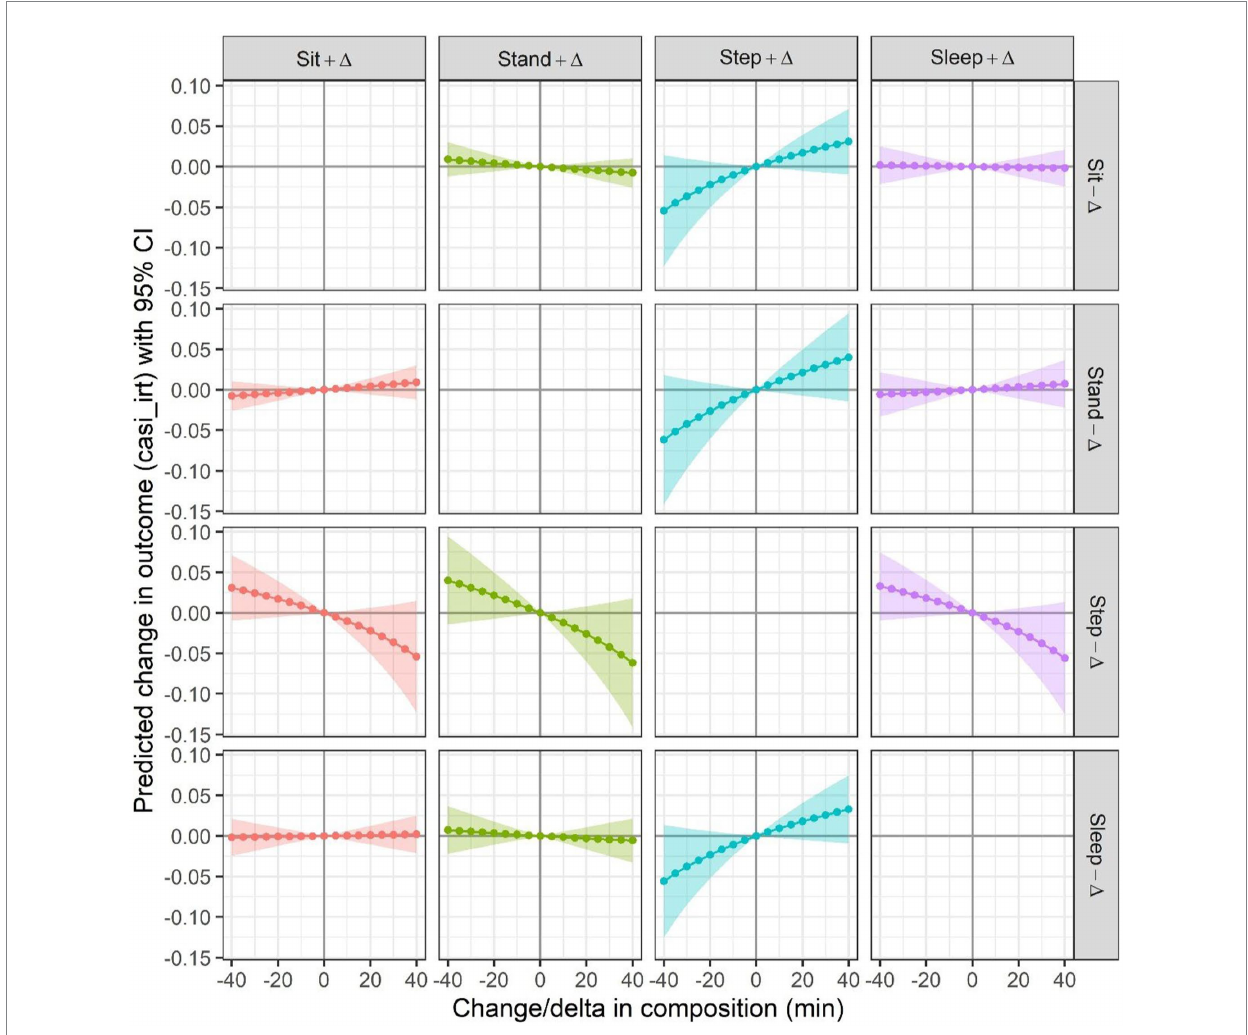
FIGURE 3 Predicted difference in outcome from CoDA when reallocating time from one behavior to another, for all possible pairwise reallocations. N = 1000 (34 observations were not included due to missing values on covariates). Each one of 16 subgraphs presents a curve of the predicted difference in mean outcome for increasing time/day on one behavior (indicated in the column header) by ∆ mins, while decreasing time/day on another behavior (indicated in the row header, i.e., gray vertical bar on the right) by the same amount of time. The curve presented in each graph is estimated based on the fitted model with CASI-IRT score as the outcome, and with any ilr -coordinates as predictors in which the behavior (indicated in the header of the subgraph) as the numerator behavior in the pivot coordinate, adjusted for age group (65–74, 75–84, 85+), sex, non-Hispanic White (Yes, No), body mass index, depressive symptoms score, and self-rated health condition. The shaded area in each subgraph corresponds to pointwise 95% confidence intervals. The baseline composition equals to the compositional mean in the sample, i.e., 10.2 h (42.6%) sit, 3.7 h (15.3%) stand, 1.2 h (5.2%) step and 8.8 h (36.9%)